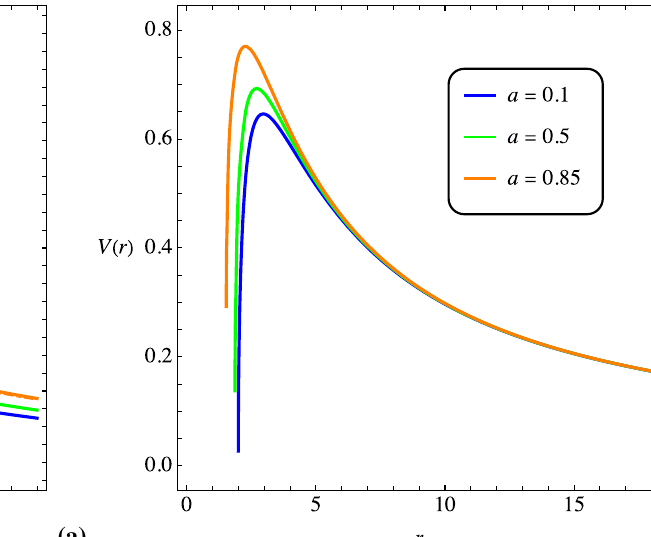
( a ) (b) a . The dot-dashed curve in the diagram a , corresponds to the retrograde motion, which has been plotted for a = − 0 . 85 M and L = 3 M (For these diagrams and for all the forthcoming ones within this paper, the unit along the axes is considered to be M )